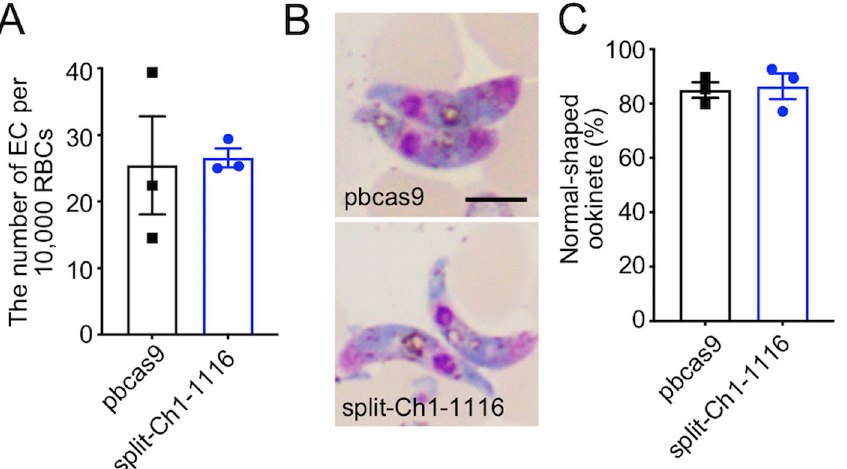
Fig 4. Sexual development of the split-Ch1-1116 parasites. (A) The number of exflagellation centers of split-Ch1- 1116 parasites were comparable to that of pbcas9 parasites. The column and error bars indicate the mean and standard error from biological triplicates. (B and C) Ookinete shape and conversion rate were normal in the split-Ch1-1116 parasites. The columns and error bars indicate the mean and standard error of the mean from biological triplicates. Distributions in A and C were compared using the unpaired t -test (not significant). The bar indicates 5 μ m.